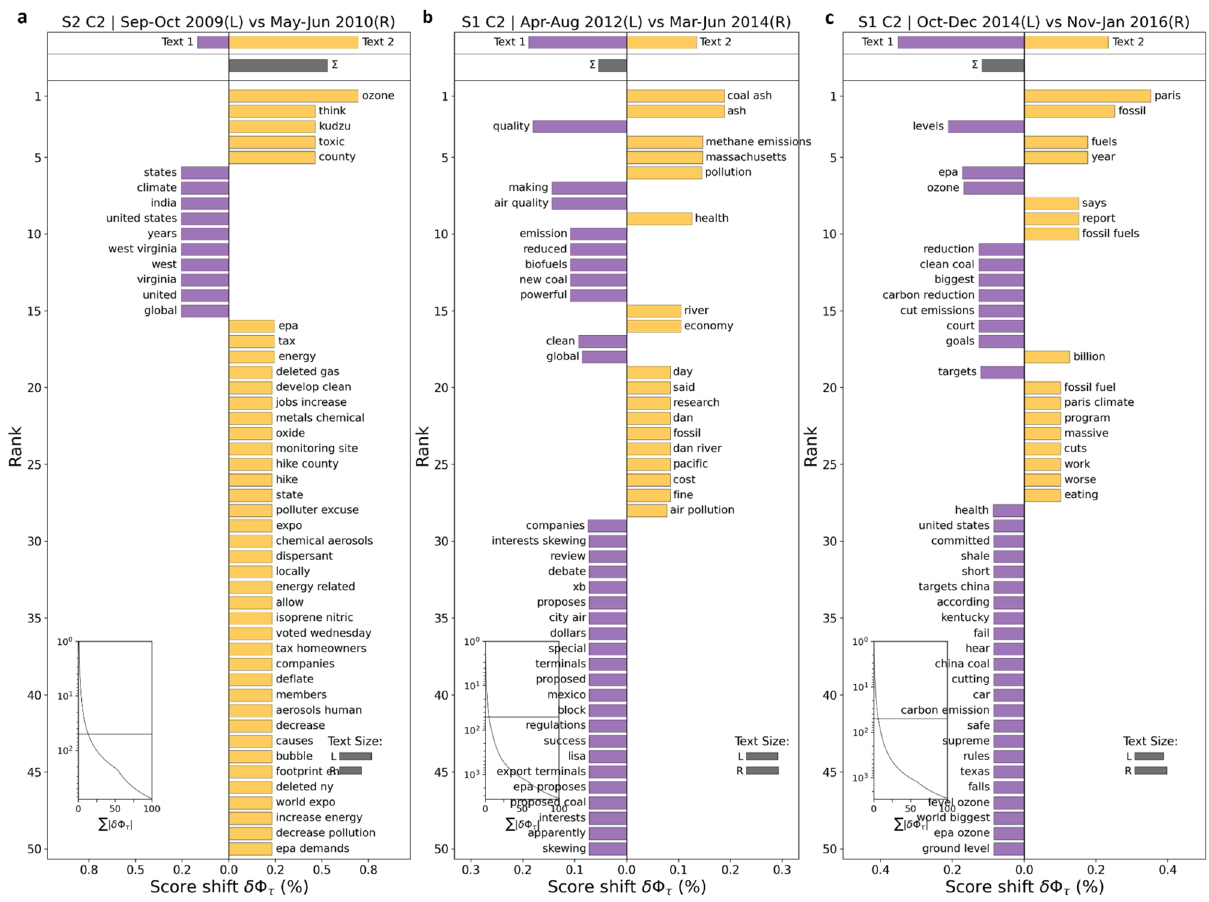
Figure 11. Word shift graphs for Carbon [emissions] cluster showing the texts from the time periods with unusually high vs. low user activity. The discussions within the Carbon [emissions] cluster spiked in